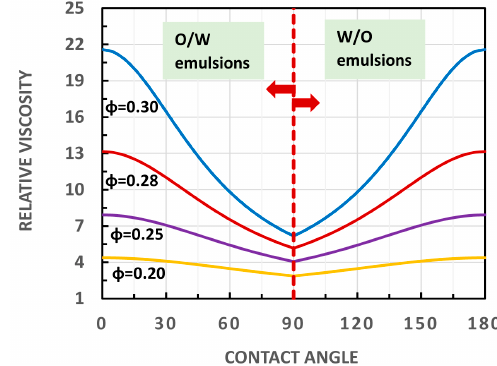
Figure 9. Model predictions of relative viscosity versus contact angle of oil-in-water (O/W) and water- in-oil (W/O) Pickering emulsions for different volume fractions of bare droplets.